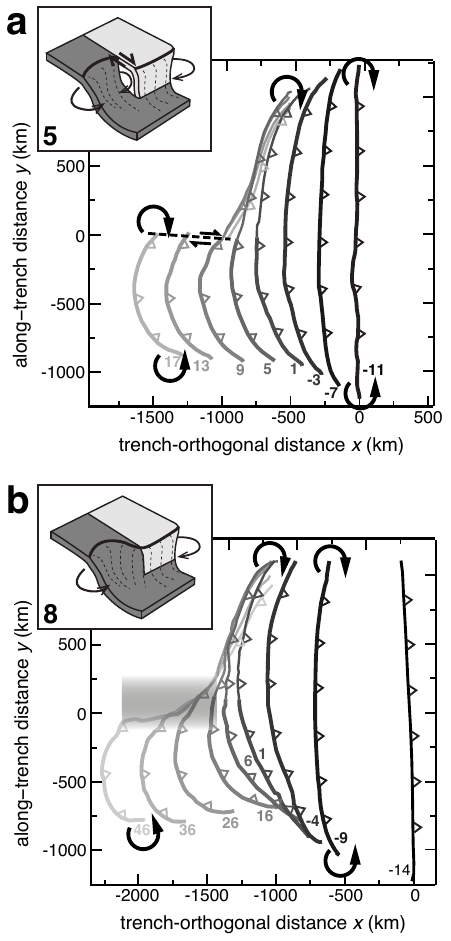
Fig. 4. Evolution of horizontal trench shape for models (a) 5 and (b) 8. Thick and thin lines indicates locations of oceanic and conti- nental subductions, respectively. Numbers at the bottom indicate the time after subduction of continental lithosphere in Myr. Dashed line in (a) indicates the location of the tear fault and grey box in (b) the area where the slab deforms to accommodate differential roll-back velocities. Black arrows show schematic mantle flow pattern asso- ciated with subduction. Insets show 3-D sketches of the subducting plate shape at the end of each